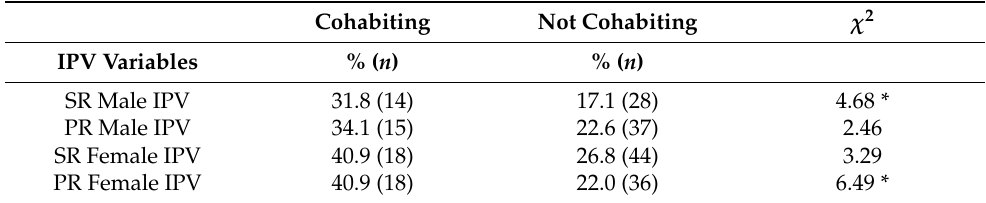
Table 7. Proportions of self-reported and partner-reported male and female IPV perpetration across cohabiting and non-cohabiting